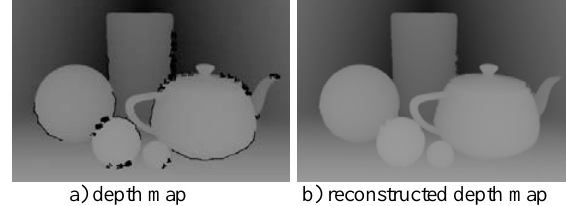
Fig. 8. Processing